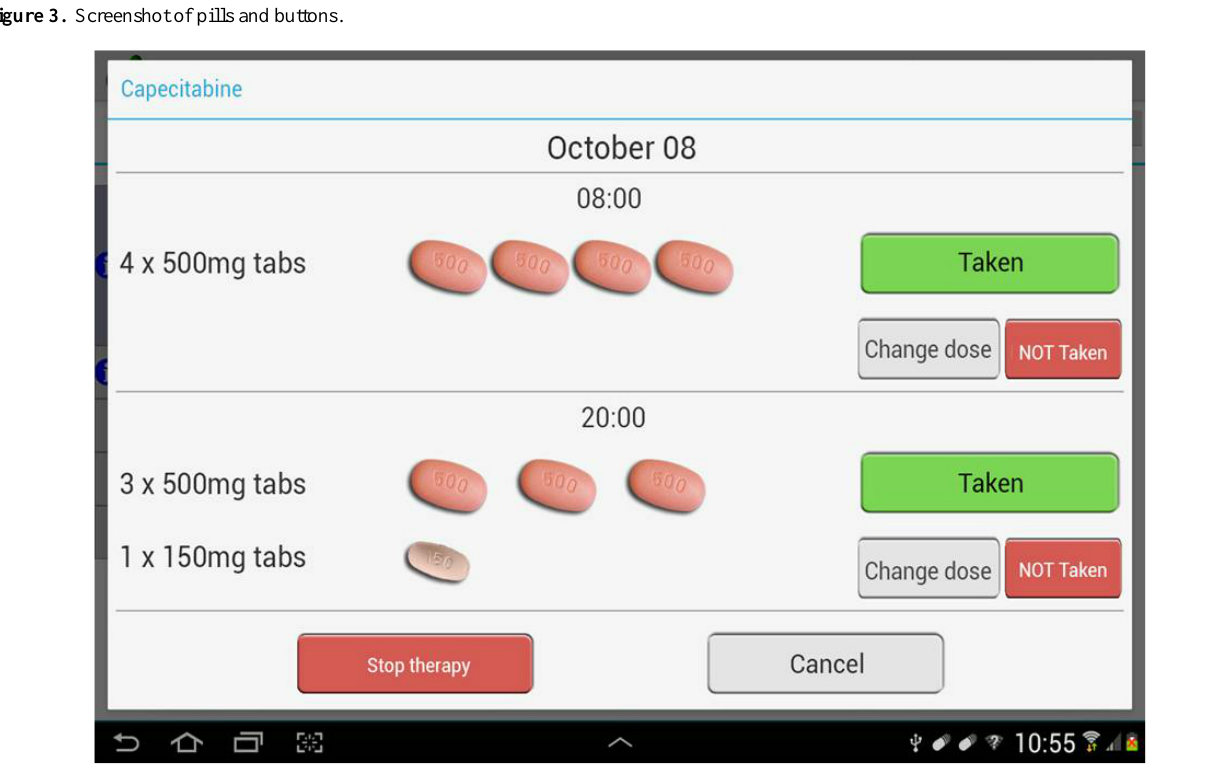
Figure 3. Screenshot of pills and